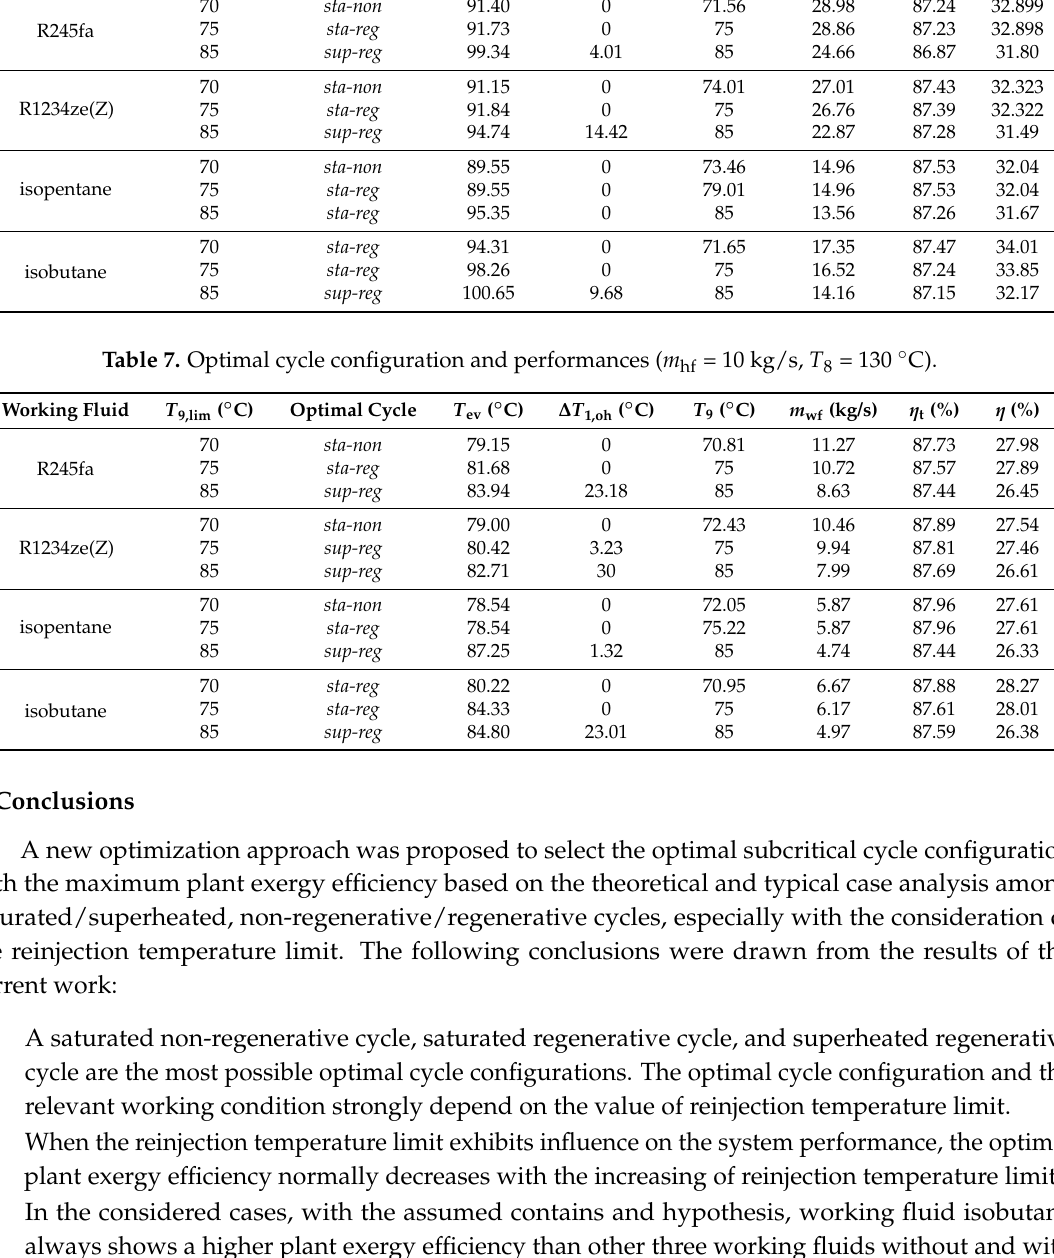
Table 6. Optimal cycle configuration and performances ( m hf = 20 kg/s, T 8 = 150 ◦ C). Working Fluid